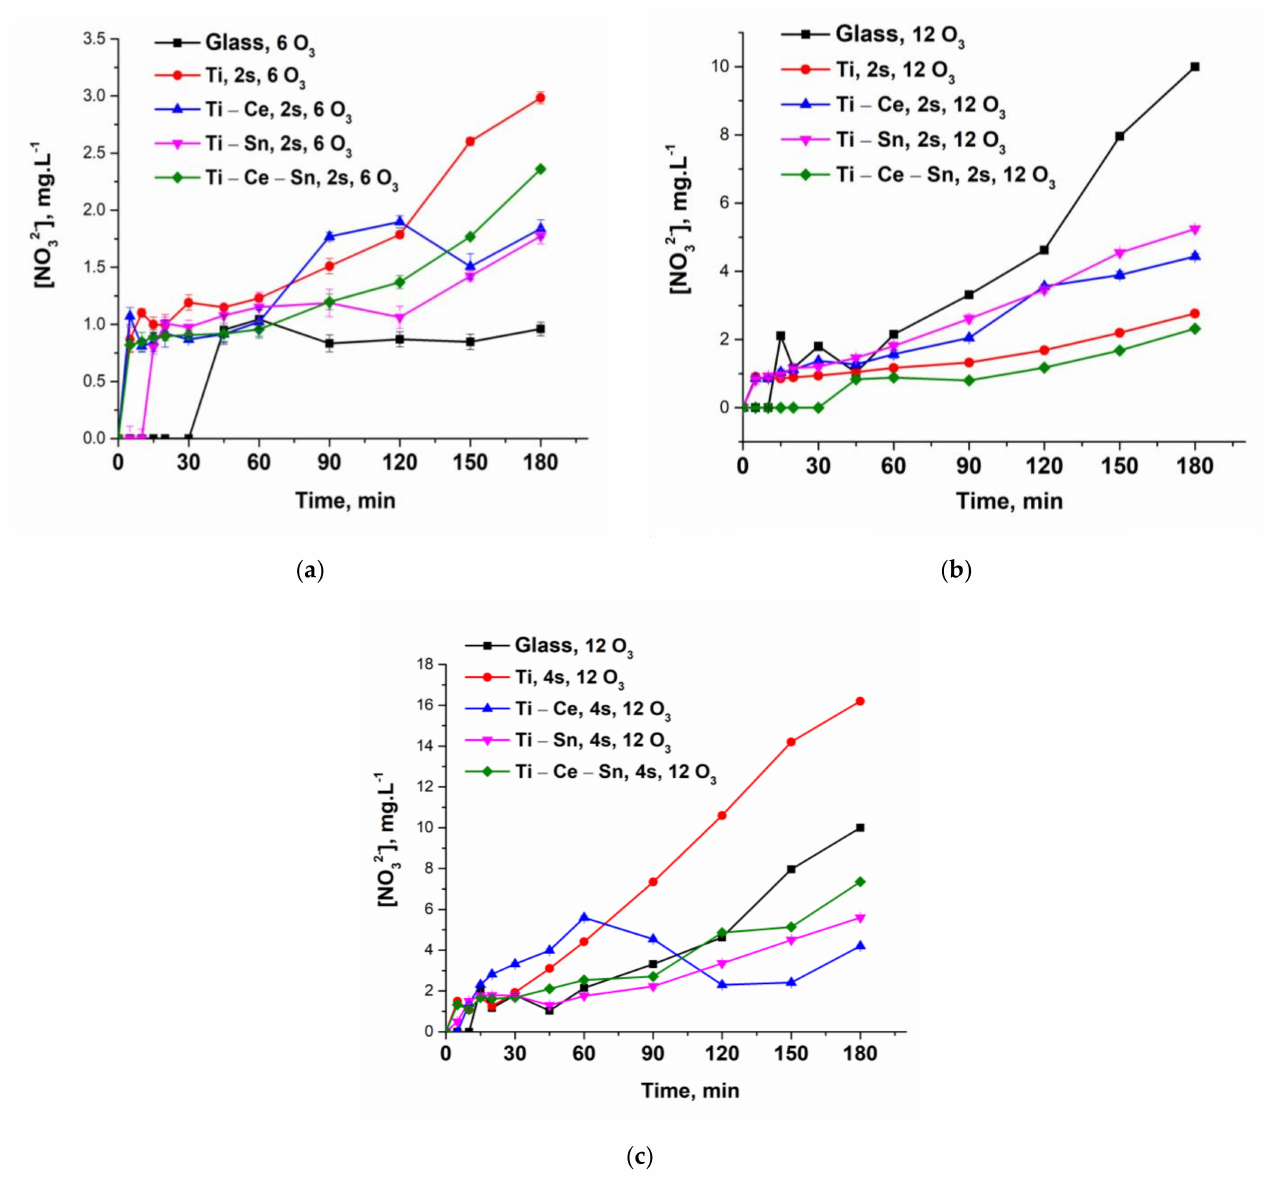
Figure 11. ( a ) Evolution of nitrate ions for all prepared systems at a lower ozone input and two slides; ( b ) Evolution of nitrate ions for all prepared systems at a higher ozone input and two slides; ( c ) Evolution of nitrate ions for all prepared systems at a higher ozone input and four